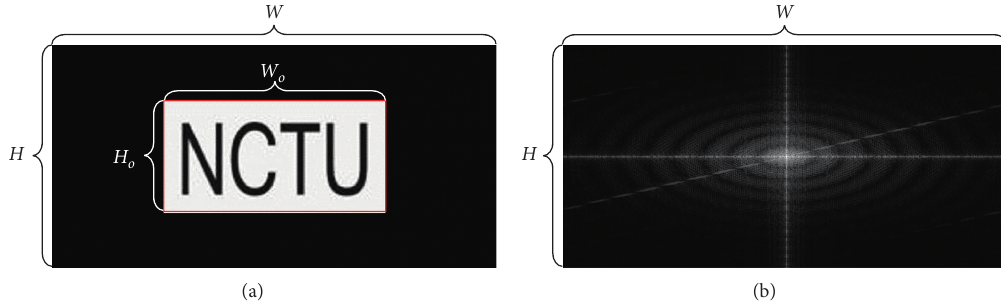
Figure 7: (a) The original object image is zero-padded to W × H such that the oversampling condition is satisfied. The red rectangle divides the spatial domain into the inside and outside of the support region. (b) The oversampled diffraction pattern of (a) is used as the Fourier measurement. Here, the spectrum is displayed on a logarithmic scale for visualization purposes.